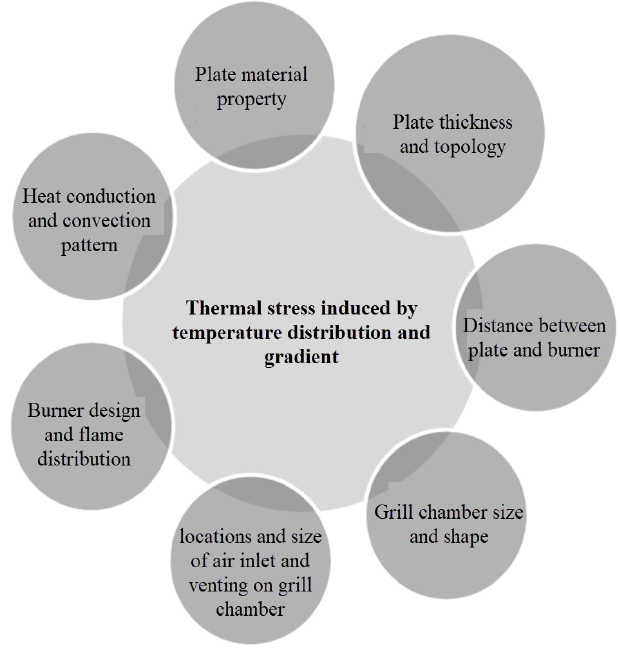
Figure 18. Coupling Model Integration Diagram.